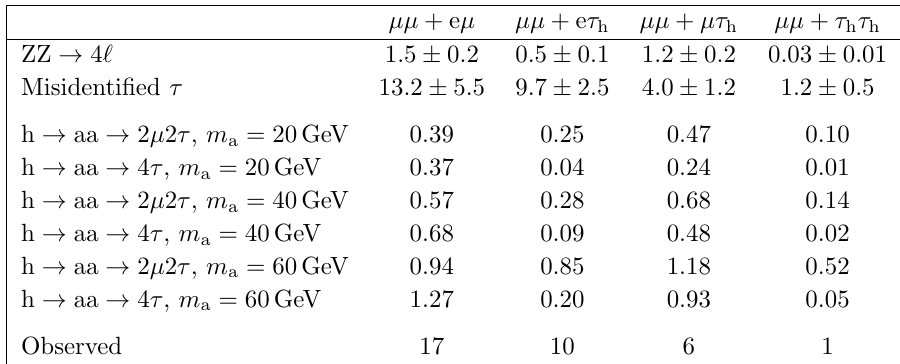
Figure 3 . Dimuon mass distributions in the (cid:22)(cid:22) + e (cid:22) (upper left), (cid:22)(cid:22) + e (cid:28) h (upper right), (cid:22)(cid:22) + (cid:22)(cid:28) h (lower left), and (cid:22)(cid:22) + (cid:28) h (cid:28) h (lower right) (cid:12)nal states. The total background estimate and its uncertainty are given by the black lines. The histograms for the two background components are shown for illustrative purposes only as the background models are extracted from unbinned (cid:12)ts. The signal model is drawn in blue above the background model: it includes both h ! aa ! 2 (cid:22) 2 (cid:28) and h ! aa ! 4 (cid:28) , and is normalized using B (h ! aa ! 2 (cid:22) 2 (cid:28) ) = 0 : 01%, assuming the relation in eq. (1.1) to determine the relative proportion of these processes. The production cross section of the Higgs boson predicted in the SM is assumed.